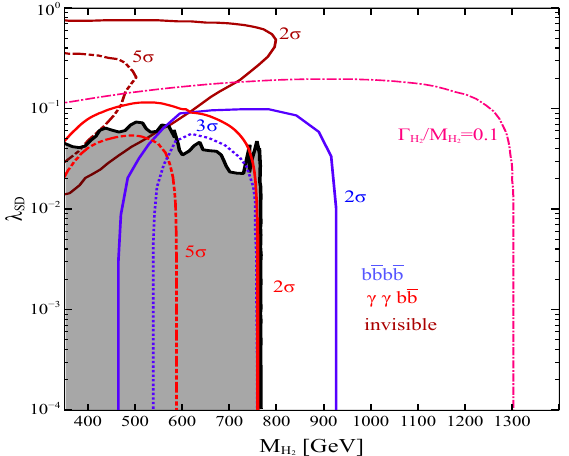
Figure 17 . HL-LHC prediction for pp → H 2 jj → jj + MET , pp → H 2 → H 1 H 1 → 2 b + 2 γ and pp → H 2 → H 1 H 1 → 4 b indicated by brown, red and blue color contours in M H Black shaded region is ruled out from the ATLAS search for H